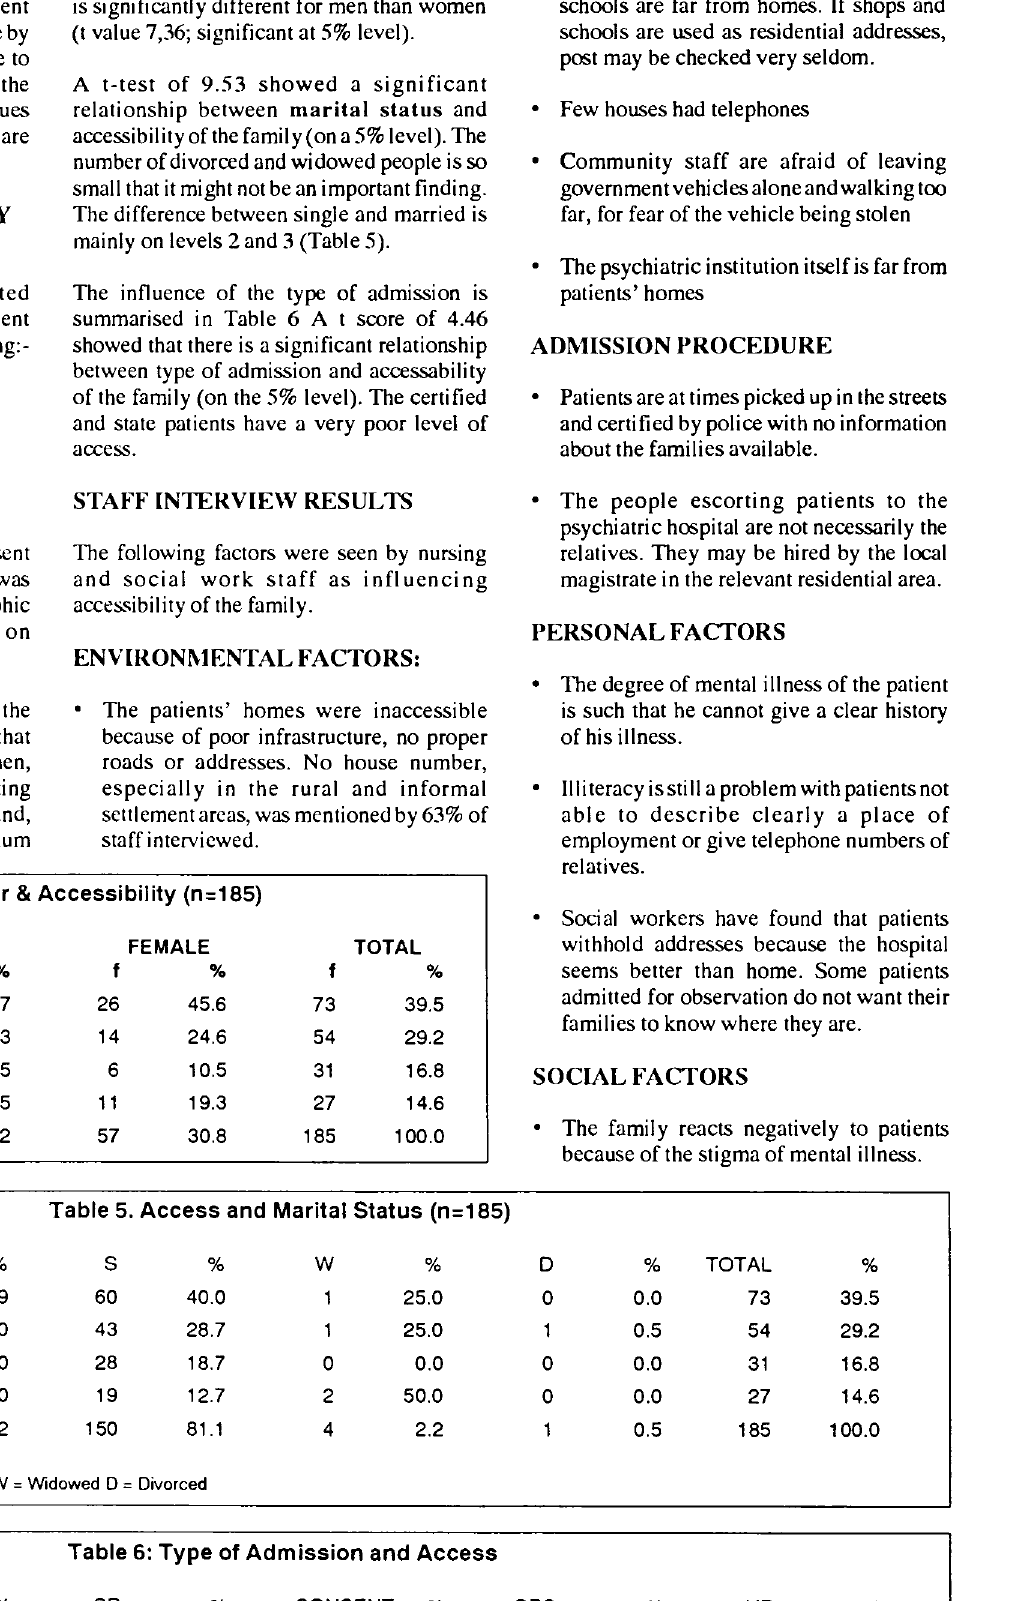
Table 6; Type of Adnfilssion and